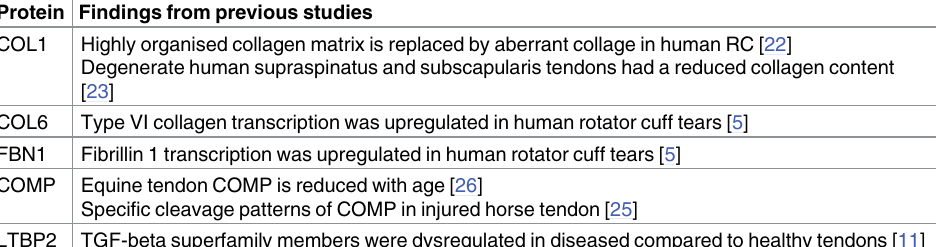
Table 6. Previously published studies confirming the disruption of COL1, COL6, FBN1, COMP and LTBP2 in torn and/or aged tendons. Protein Findings from previous